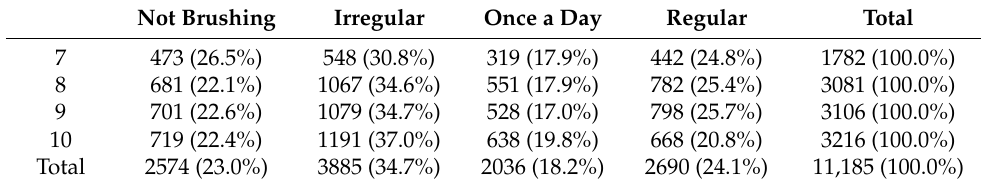
Table 4. Children’s tooth brushing habits [n (%)].